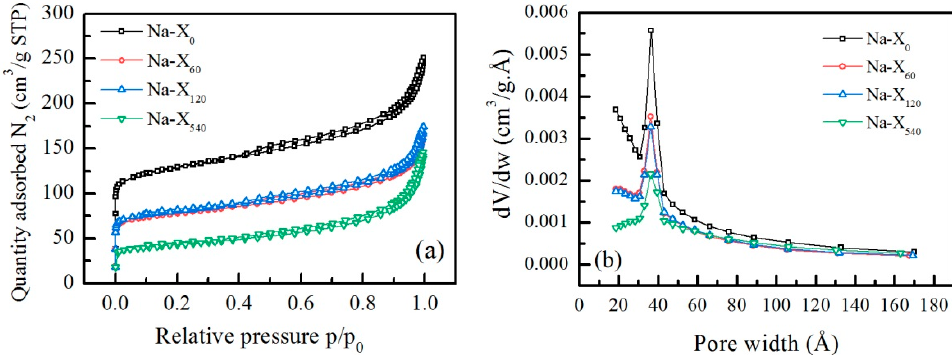
Figure 2. Experimental N 2 adsorption/desorption isotherms ( a ) and BJH plot of pore size distribution ( b ) of parent Na-X zeolites and zeolites after milling for 60, 120, and 540 s.